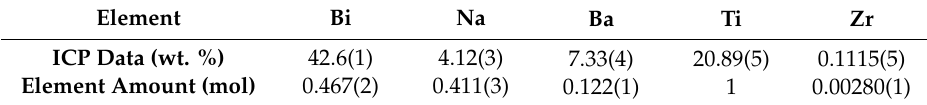
Table 1. Inductively coupled plasma (ICP) analyzes of